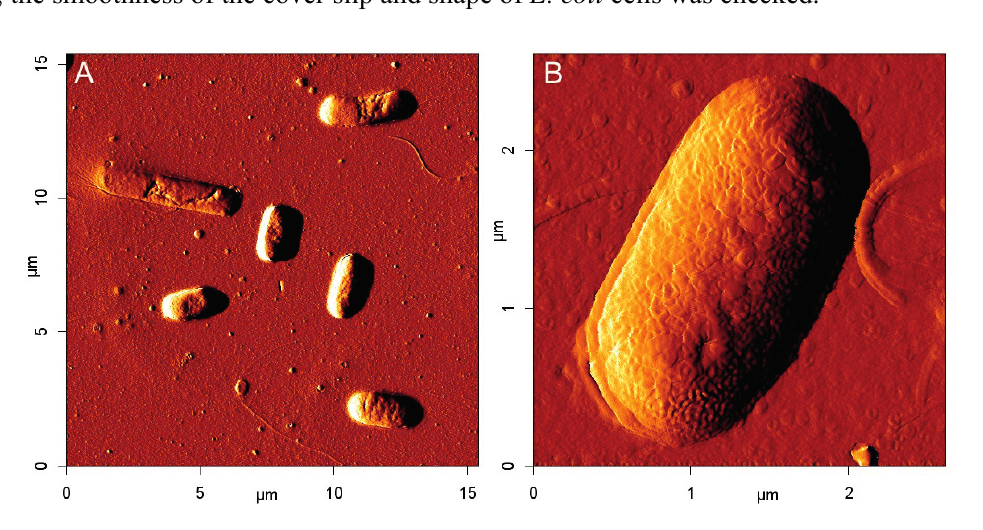
Figure 2. AFM scan of E. coli K-12 specifically bound on the cover slip modified by APTES and antibody Serotec 4329-4906. The “ Error ” signal is shown. ( A ) Overview and ( B ) detail of a single